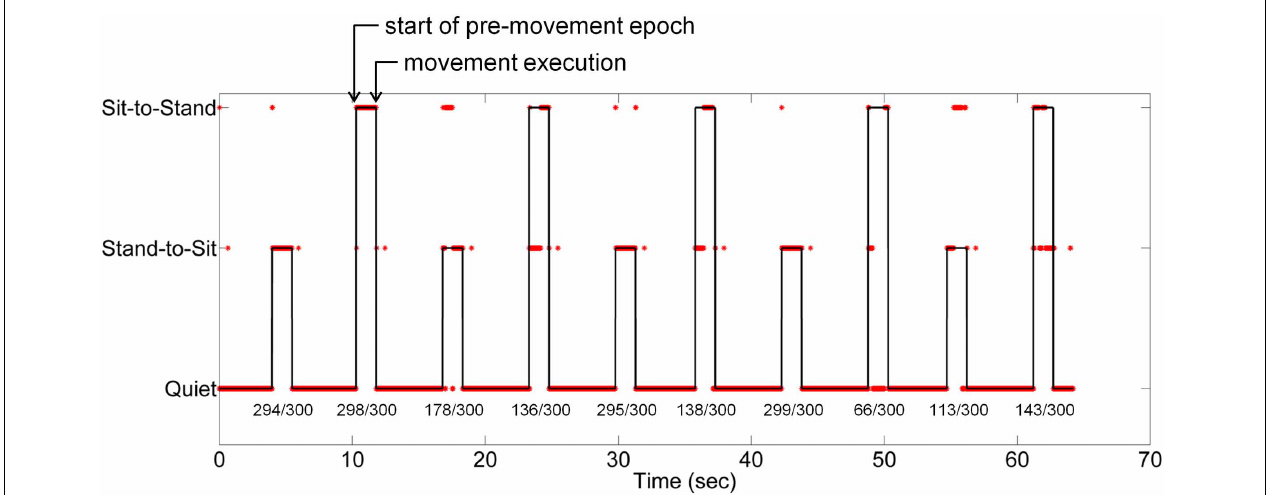
FIGURE 12 | Simulation of real-time decoding of movement intention from low frequency EEG for one subject. The classifier was trained using ASR-cleaned EEG data from the first half of the self-initiated trial; the figure contains a time series of simulated real-time classification decisions from the